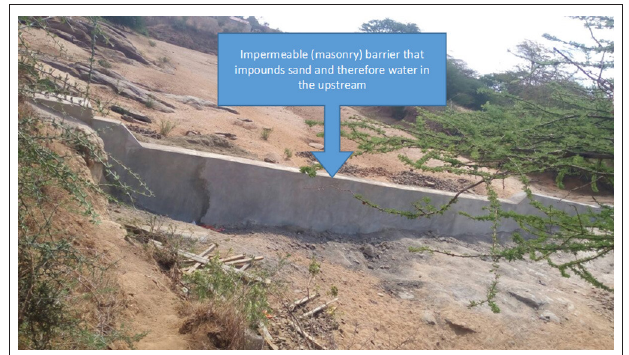
FIGURE 4 | A newly built sand-storage